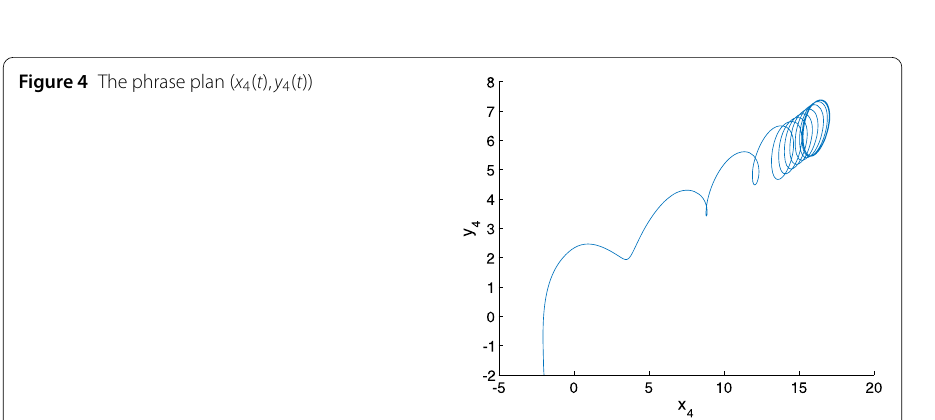
Figure 4 The phrase plan ( x 4 ( t ), y 4 ( t